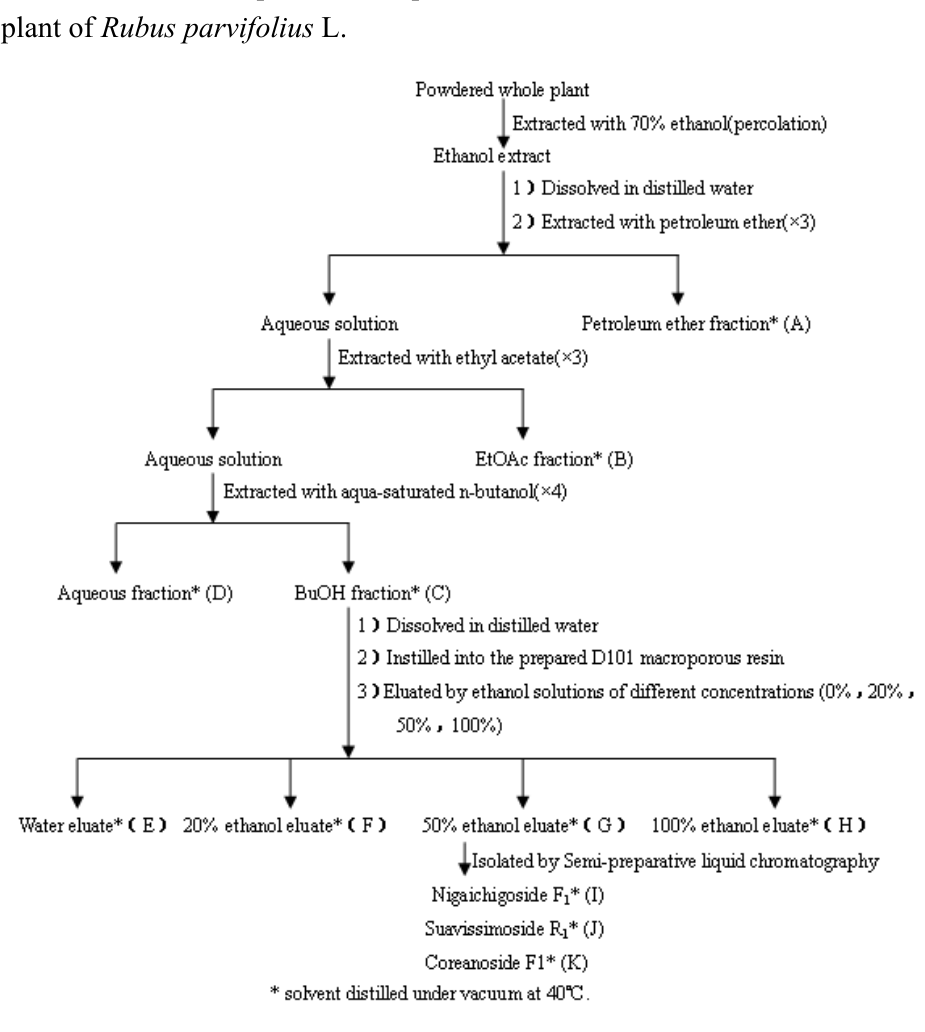
Figure 4. Schematic description of the procedures for extraction and fractionation of